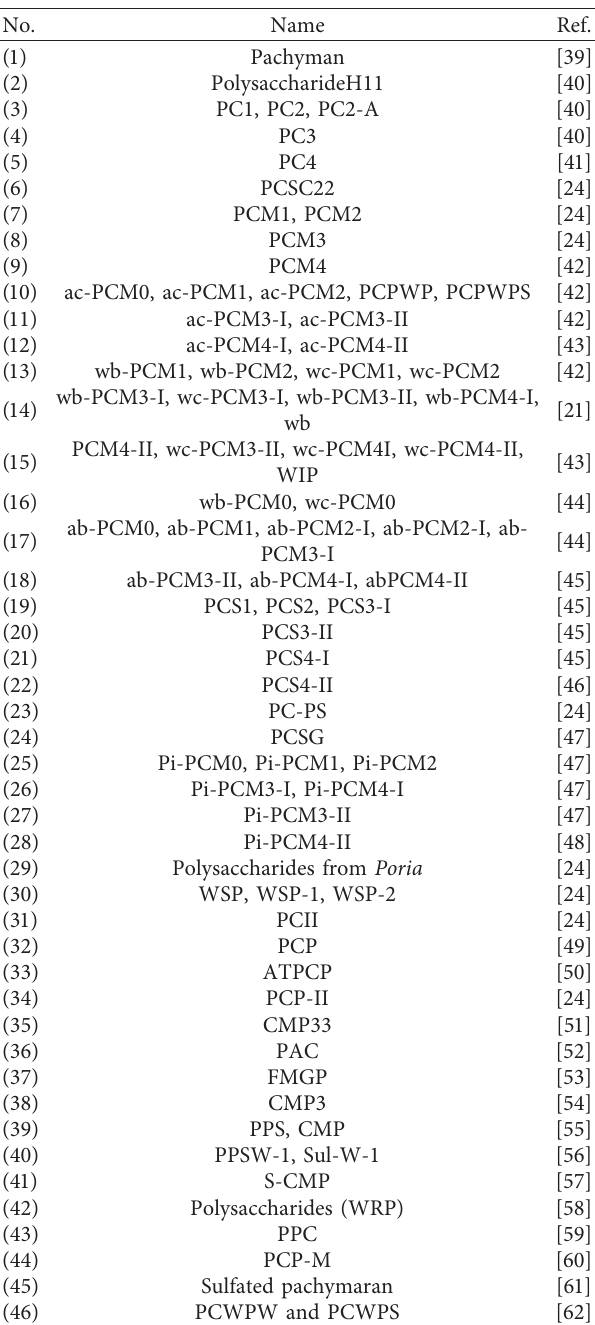
Table 2: Polysaccharides isolated from Poria . No. Name